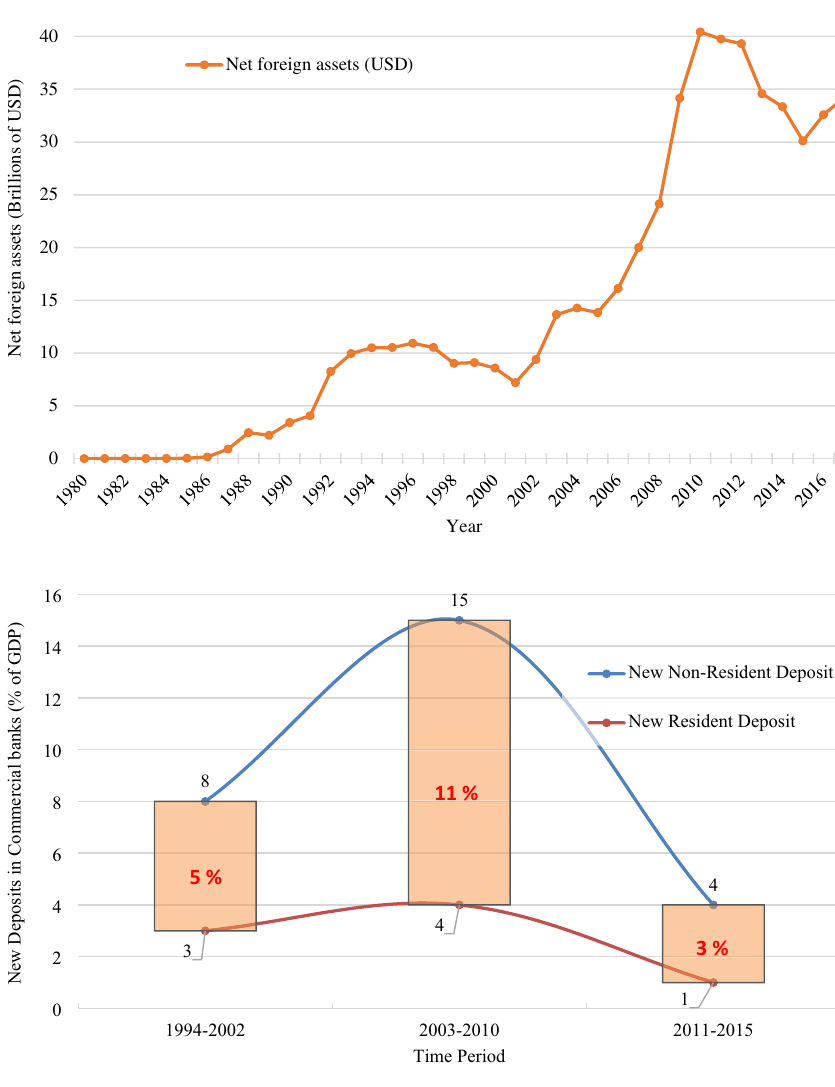
Fig. 3 Net Foreign Assets of Lebanon ( Source : World Bank Group [44])